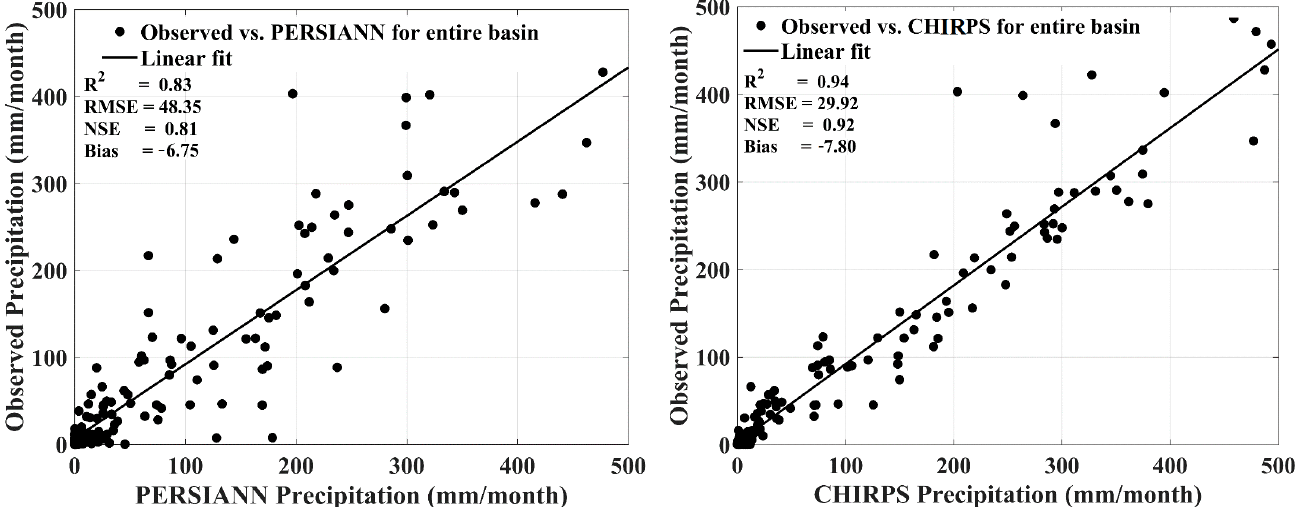
Figure 6. Scatter plots show a comparison of satellite precipitations (PERSIANN and CHIRPS) with the observed precipitation for the entire basin.